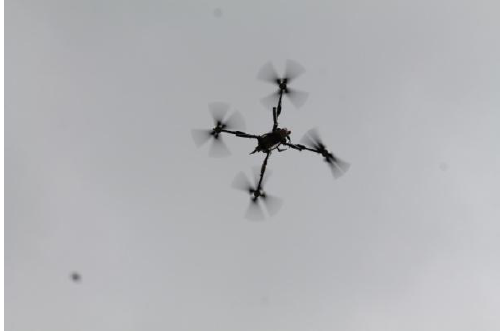
Figure 4.600 mm carbon rod coaxial